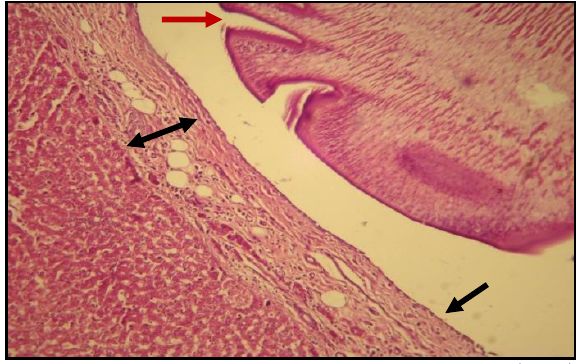
Figure, 5: Histopathological section shows parasite ( ) inside its cyst ( ) caused pressure atrophy to the adjacent hepatic parenchyma and are surrounded by thick fibrous connective tissue infiltrated with neutrophiles, mononuclear cells and plasma cells ( ) (H&E x100).